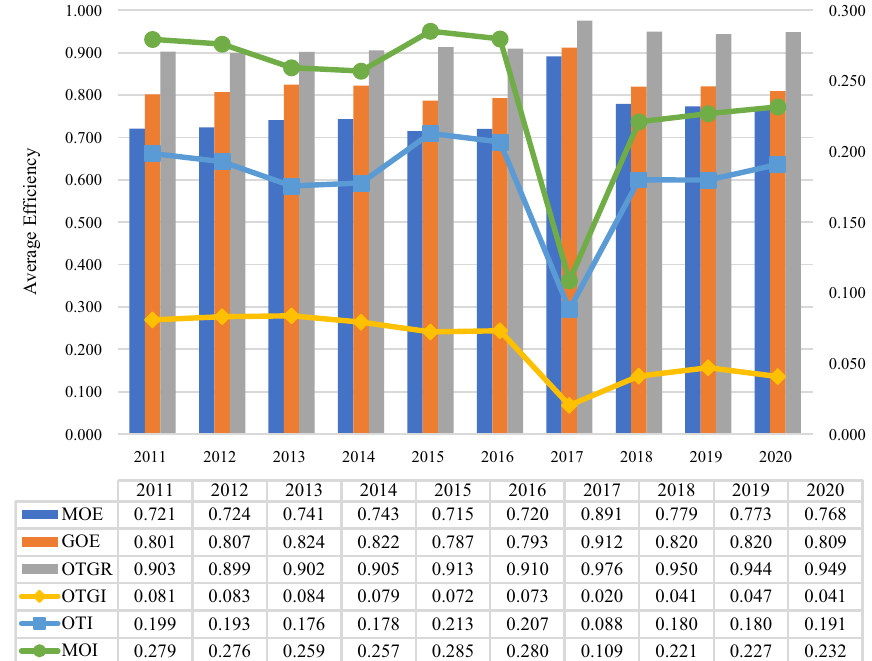
Fig. 2 The stack straight bar chart for average operational efficiencies and